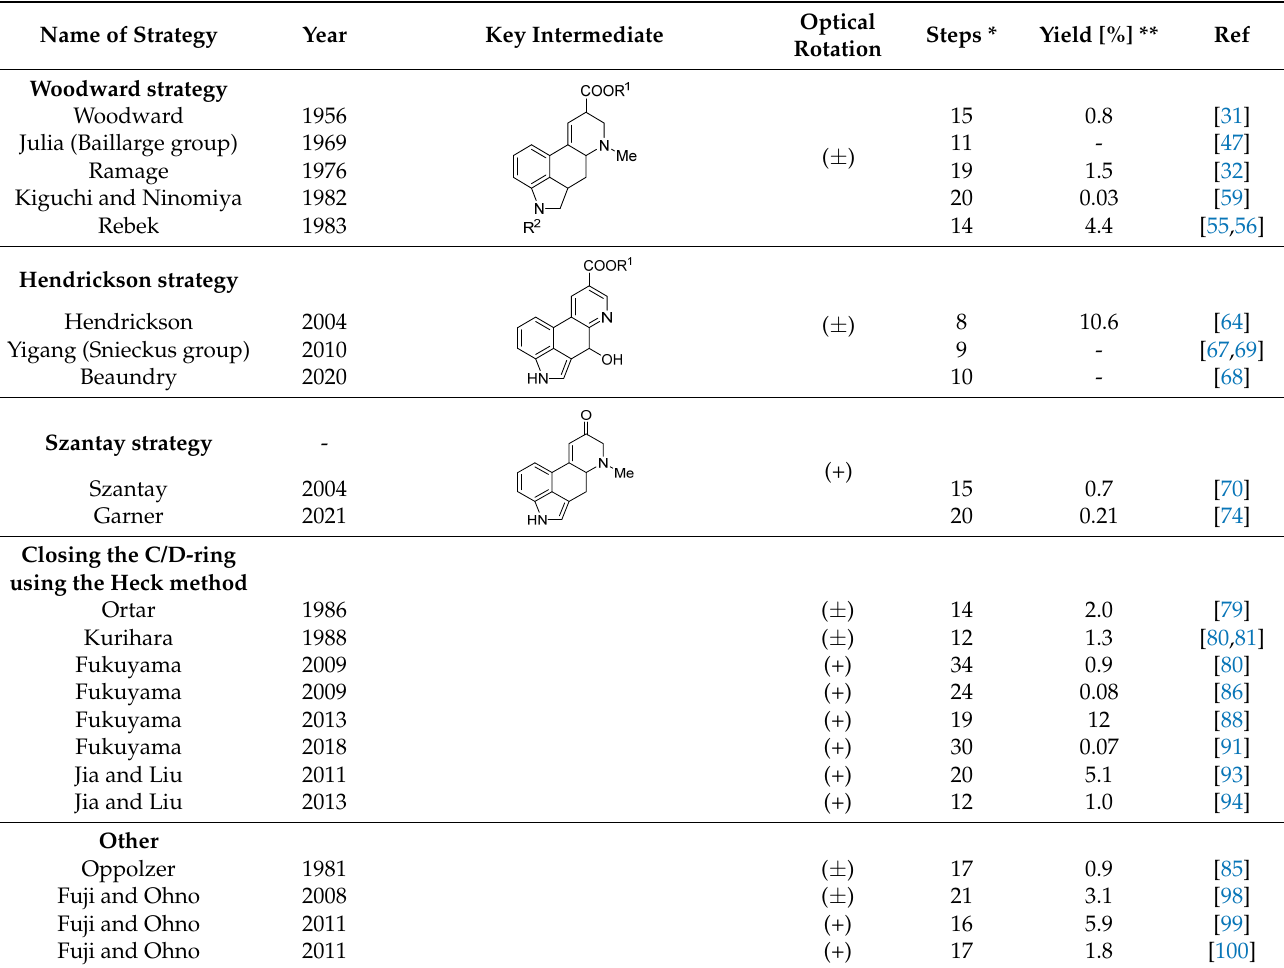
Table 2. Summary of chemical methods of obtaining lysergic acid.